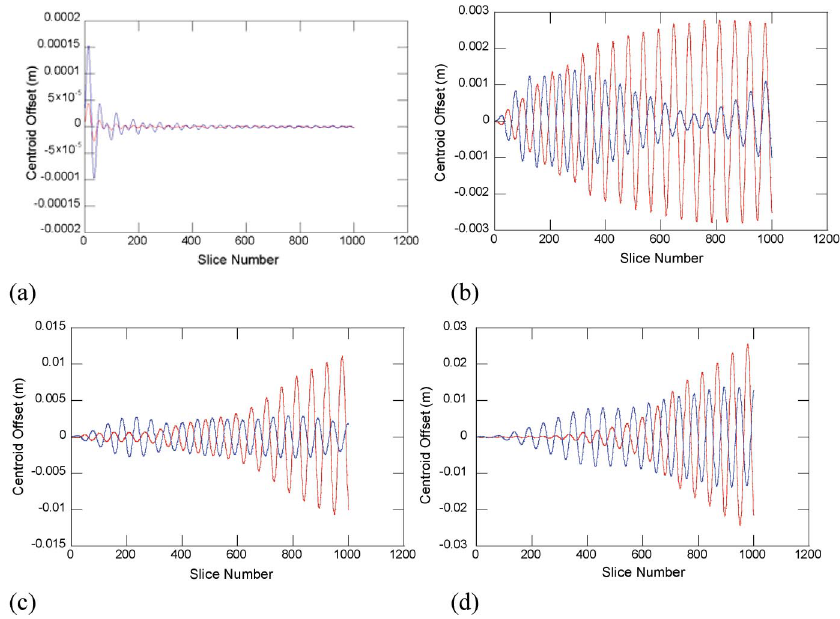
FIG. 28. (Color) Ion centroids at (a) 5 m, (b) 7.5 m, (c) 8.75 m, and (d) 10 m, for an 8 (cid:1) sec beam in the commissioning geometry, for an initial offset period of 440 nsec. The red line is for the horizontal offset and the blue line is for the vertical